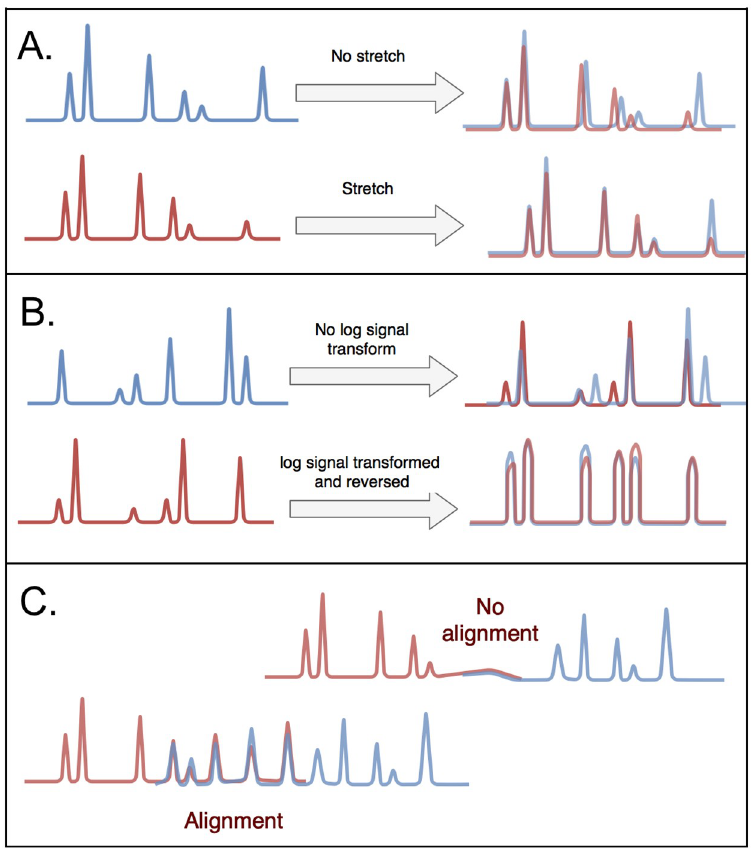
Fig 5. The OptiMap alignment procedure. A . Allowing for molecule stretching. B . Log-transformed signal correlation scores help confirm alignments based on raw signals. C . Requiring a minimum number of overlapping labels.